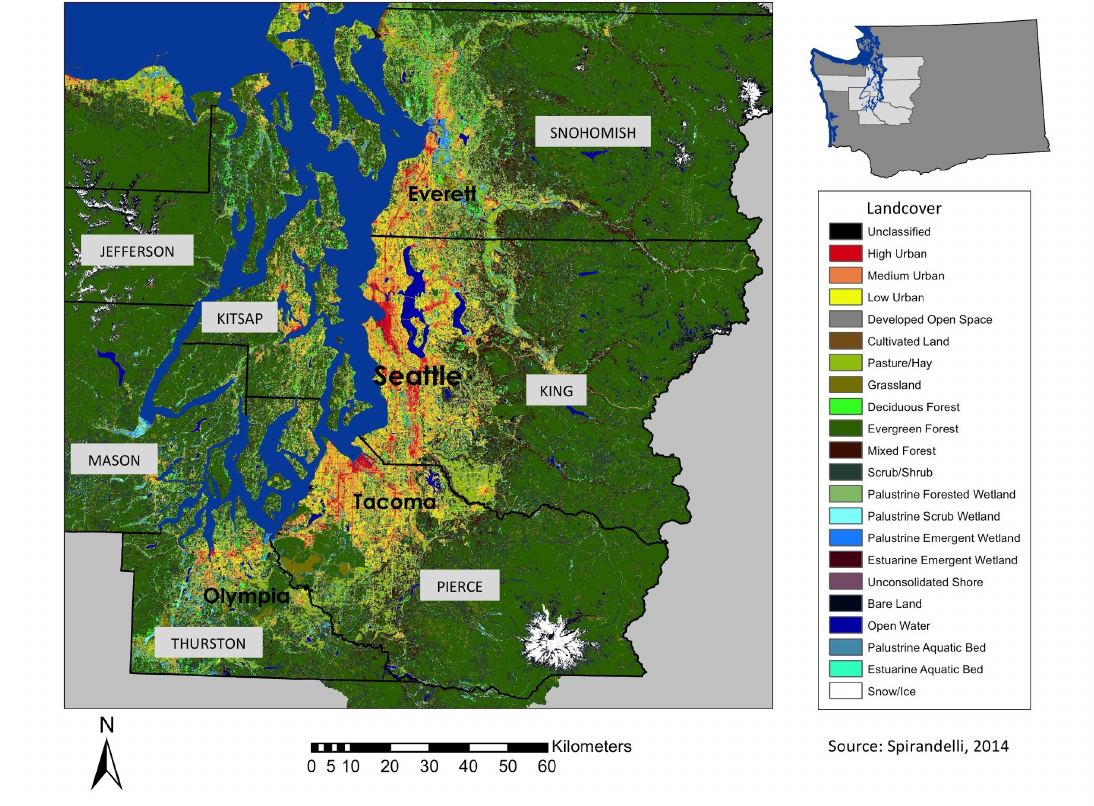
Figure 2. The study area includes seven counties of the Puget Sound, WA,